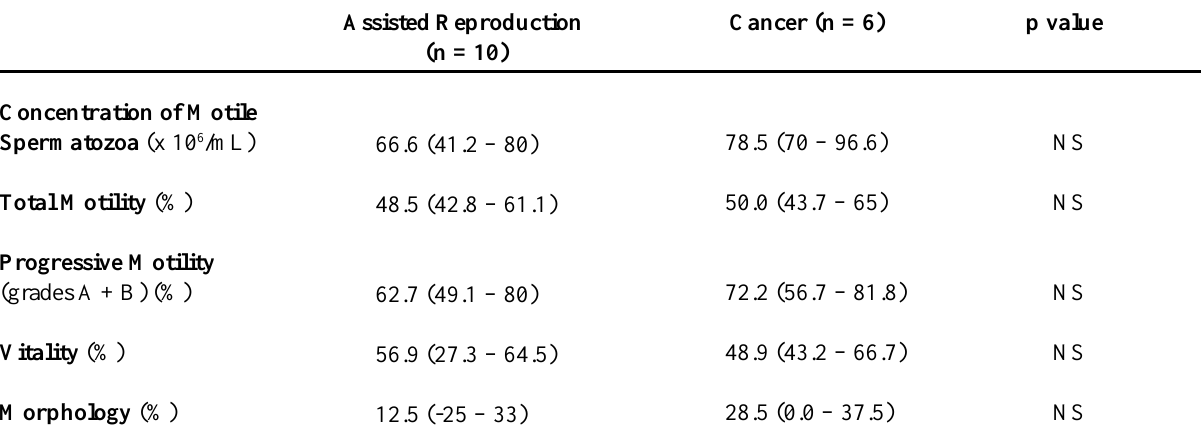
Table 3 – Percent difference between the first and the second thawing on spermatic parameters from 16 individuals in the Assisted Reproduction and Cancer subgroups. The values are expressed as median and 25 and 75